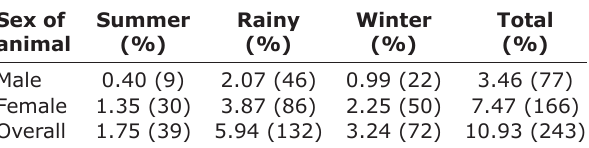
Table-3: Sex and season-wise mortality rate in Rohilkhand local goat. Sex of Summer Rainy animal (%) (%)